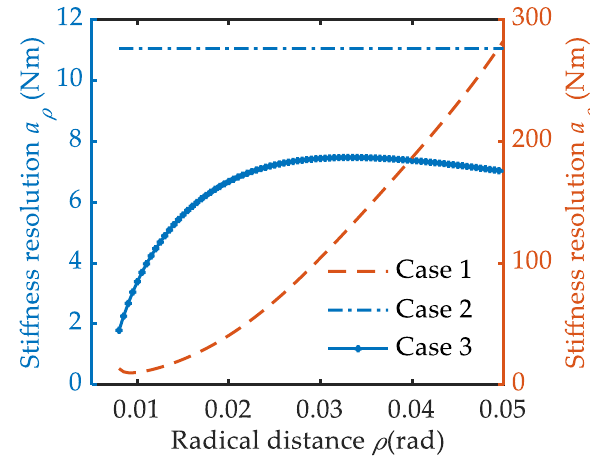
Figure 7. Shape of the pitch curve based on different cases.